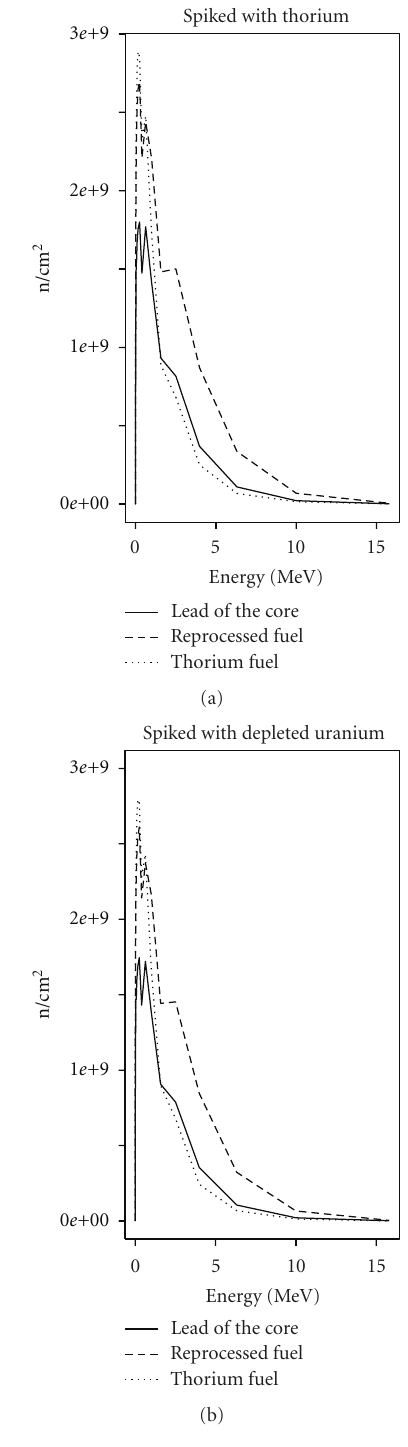
Figure 3: Neutron energy distributions in the